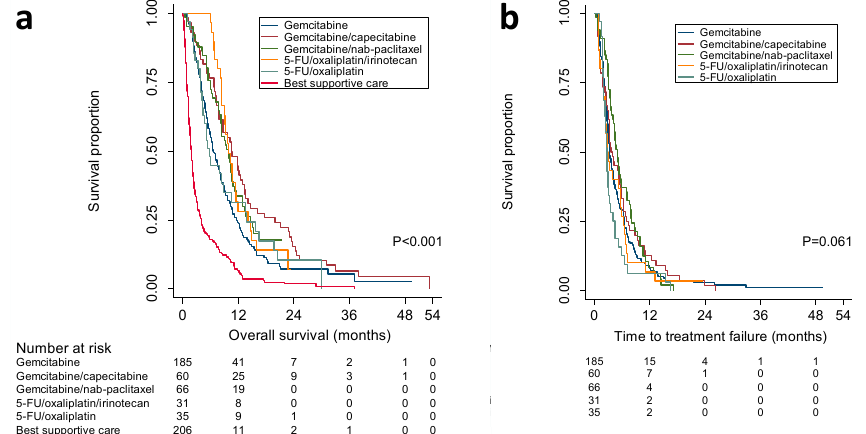
Figure 1. Kaplan–Meier analysis of ( a ) overall survival (OS) and ( b ) time to treatment failure (TTF) according to first-line therapy. OS was calculated from the first visit related to a diagnosis of pancreatic cancer until the date of death. TTF was calculated from the first visit to an oncologist until the visit at which discontinuation was decided. Patients were censored if still alive or under treatment at the date their record was accessed or at last follow-up if no information on the current status was available. Log-rank test; p < 0.05 indicates significance.